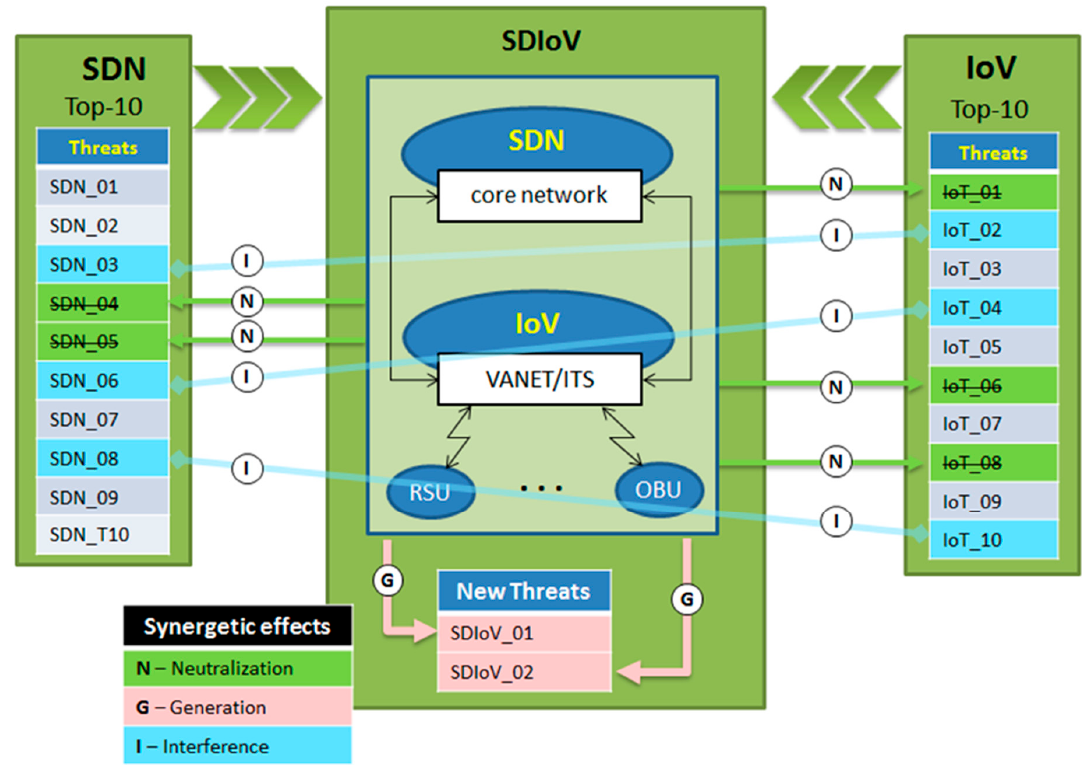
Figure 1. A concept scheme of the process of synergetic influence in SDIoV.